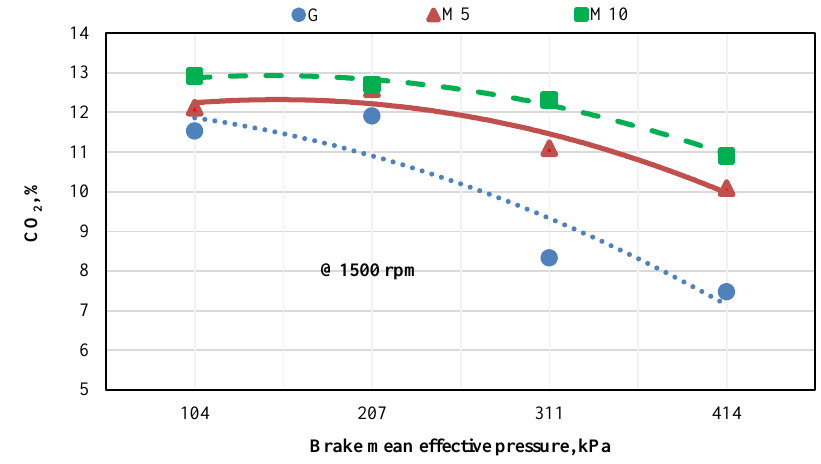
Fig. 8. CO 2 emission for tested fuels at different